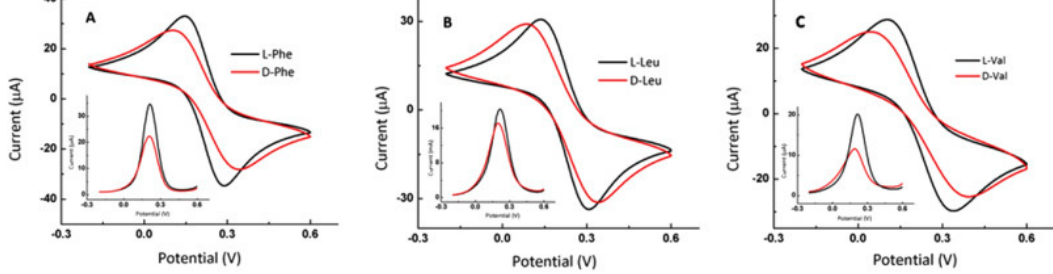
Figure 9. CV and DPV signals of D-Phe (5 × 10 − 3 mol × L − 1 ) and L-Phe (5 × 10 − 3 mol × L − 1 ) ( A ), D-Leu (5 × 10 − 3 mol × L − 1 ) and L-Leu (5 × 10 − 3 mol × L − 1 ) ( B ) and D-Val (5 × 10 − 3 mol × L − 1 ) and L-Val (5 × 10 − 3 mol × L − 1 ) ( C ) at TOCNC / L-Cys / Au electrodes in 5 × 10 − 3 mol × L − 1 [Fe (CN) 6 ] 4– / 3– solution with 0.1 mol × L − 1 KCl. Reprinted from [67] with permission of